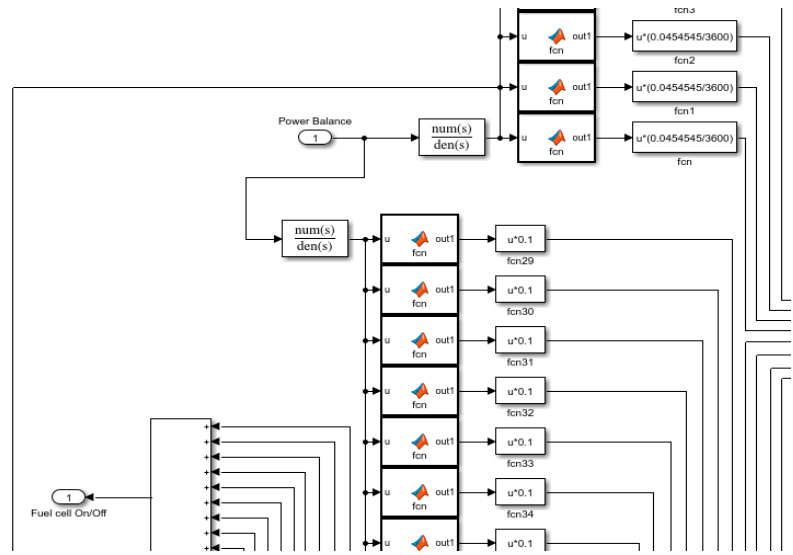
Figure 10. The subsystem of the electrolyzer cell stack (place ‘B’).